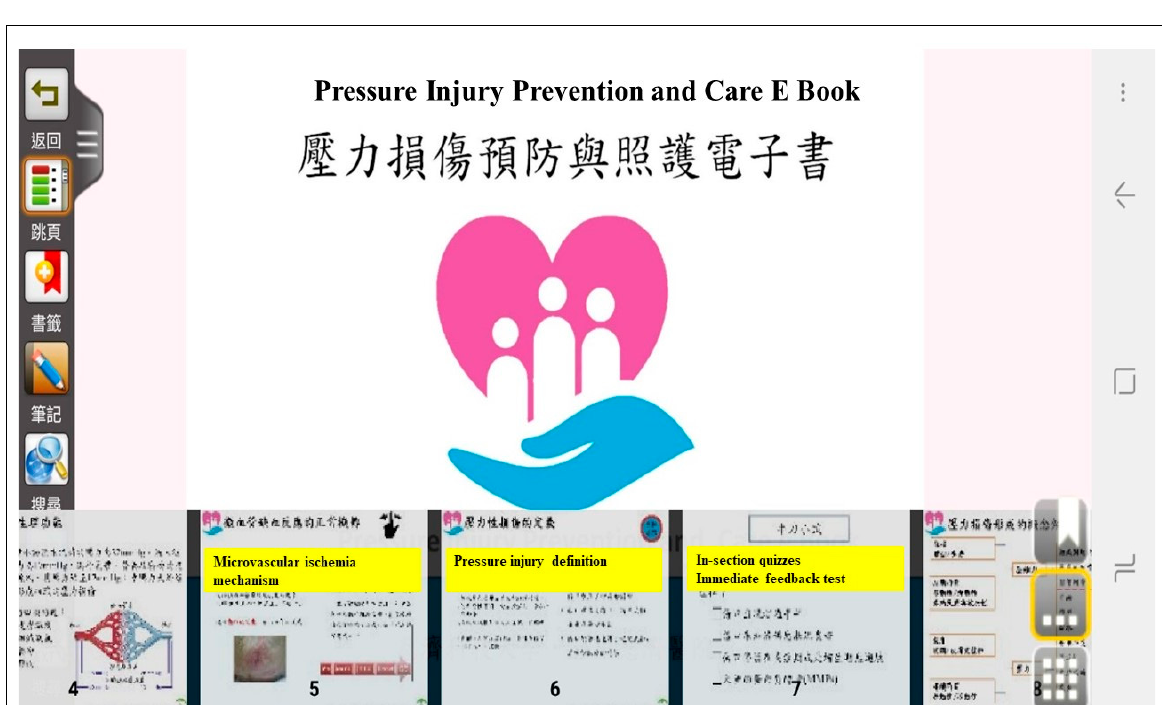
Figure A1. Pressure injury E-book